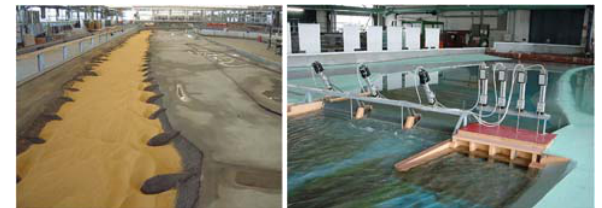
Figure 1. Test bed of a river model, pointwise gauge measurement (source